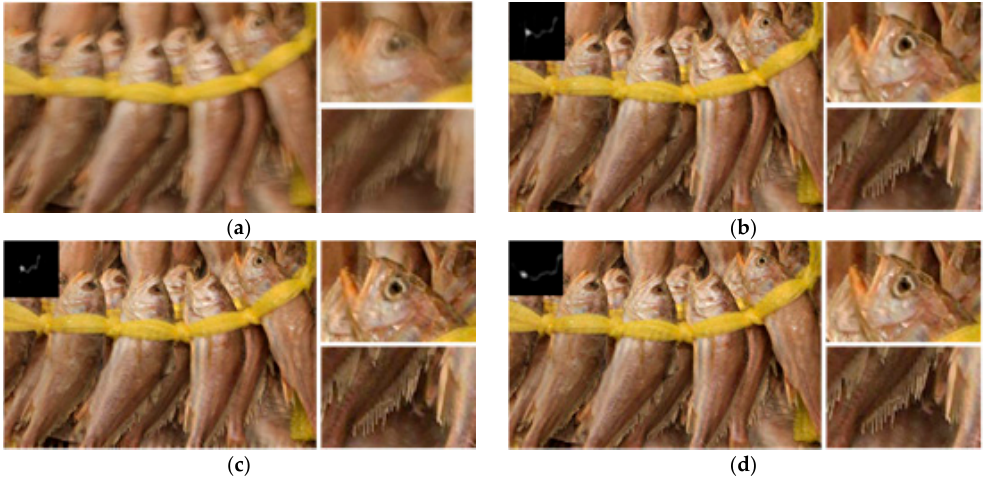
Figure 11. Comparison of different restoration algorithms on the fish image. ( a ) real burred image;